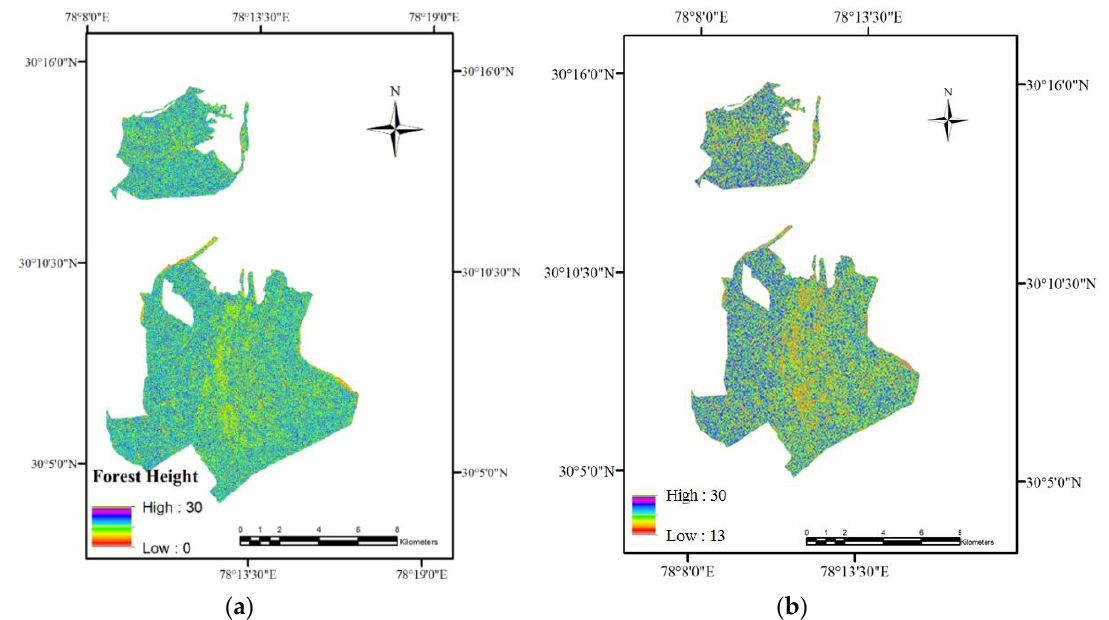
Figure 10. RADARSAT-2 inversion-based forest height for the Barkot and Thano forest ranges using ( a ) the TSI model and ( b ) the CAI model.